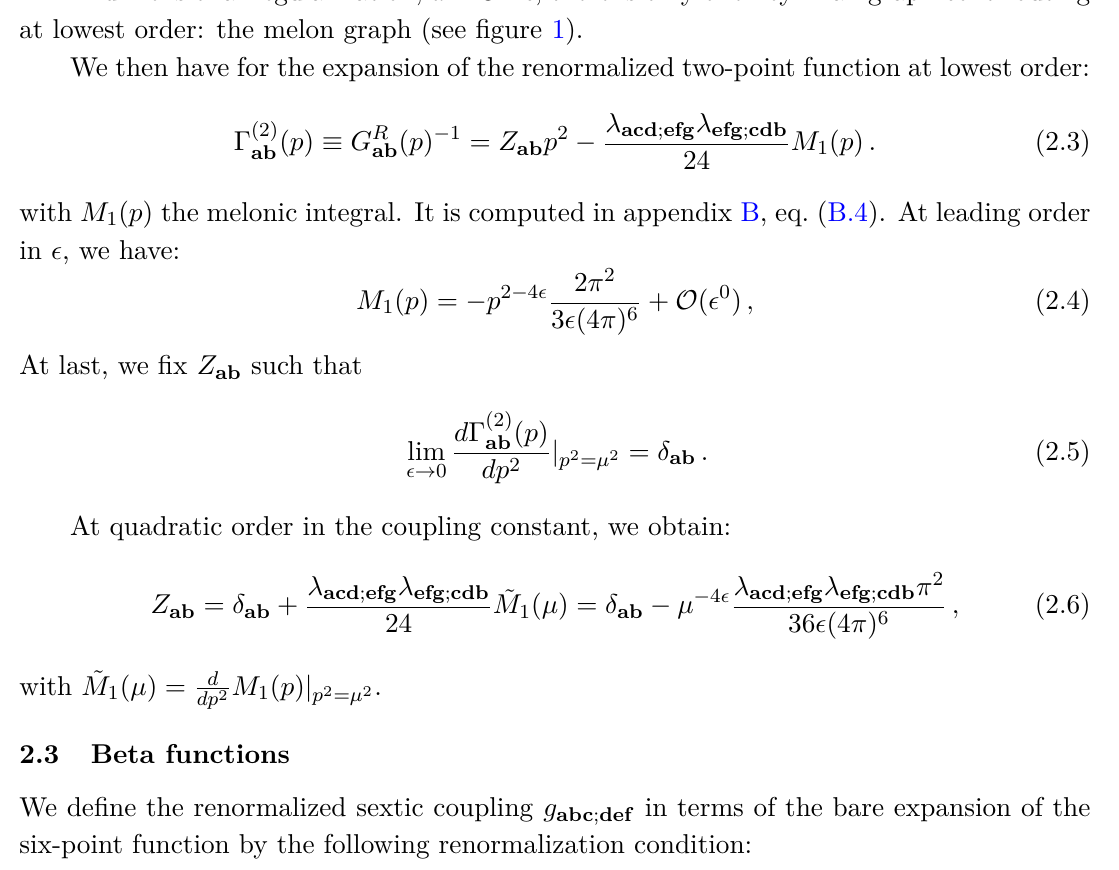
Figure 1. Two-point melon graph contributing to the wave function